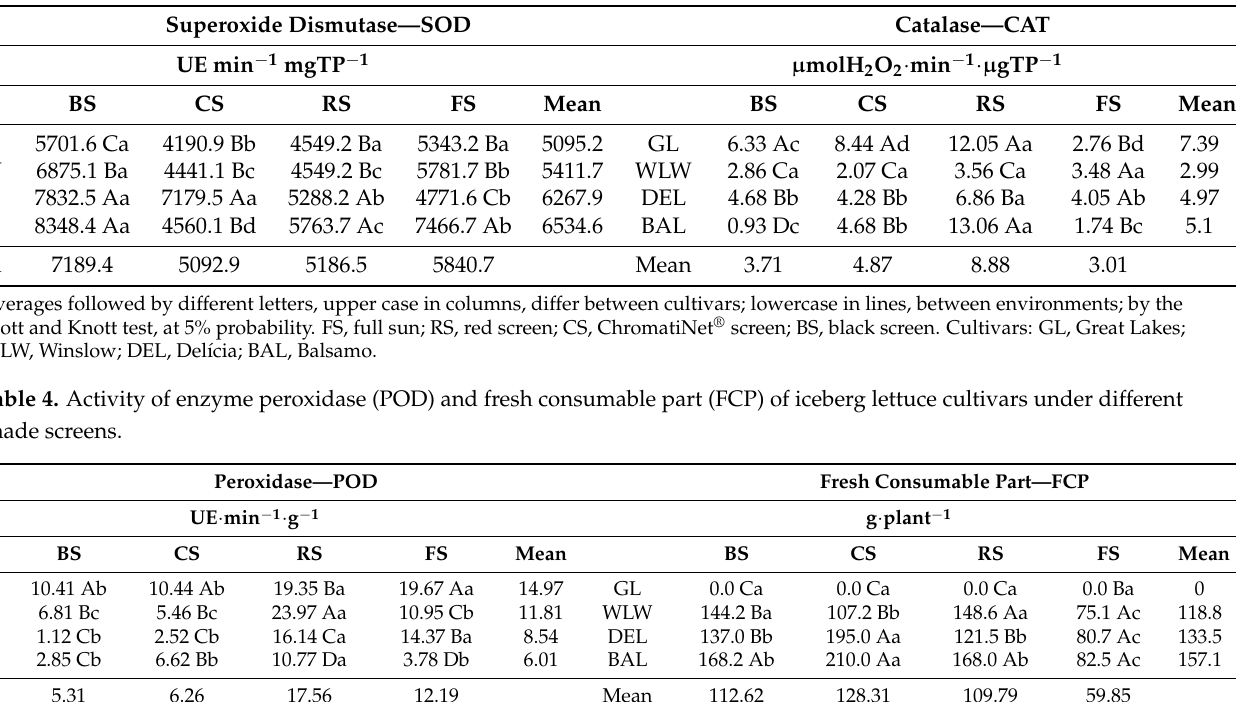
Table 3. Activity of enzymes superoxide dismutase (SOD) and catalase (CAT) of iceberg lettuce cultivars under different shade screens.